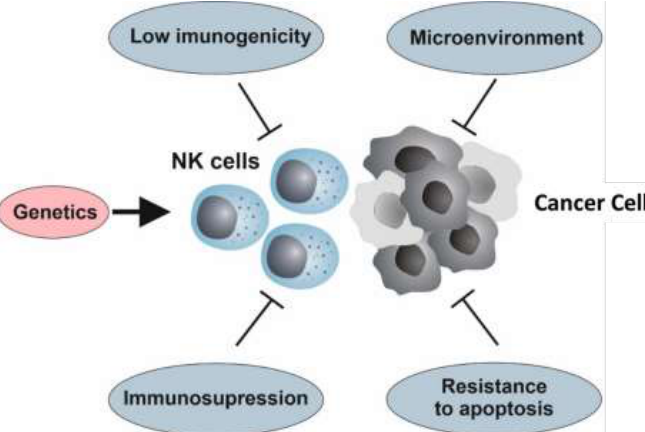
Figure 1. Resistance to natural killer (NK) cell-mediated immunotherapy. The genetic background that modulates the biology of NK cells, the resistance of cancer cells to apoptosis, and the complex interaction between the tumor and its microenvironment with the immune system—a process known as immunoediting, which may reduce the cancer’s immunogenicity, thus promoting immunosuppression—are crucial factors of tumor resistance to NK cell-based therapies.